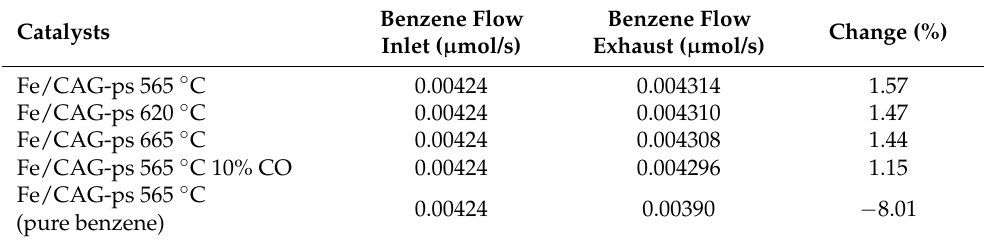
Table A4. Benzene flow in the exhaust at different temperatures and feed